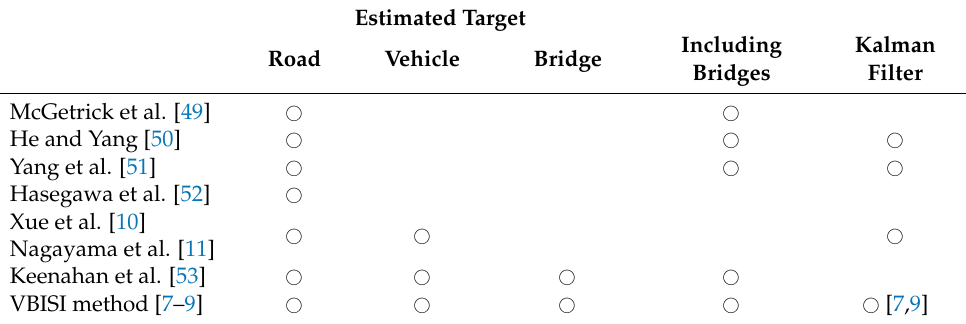
Estimated Target Road Vehicle Bridge